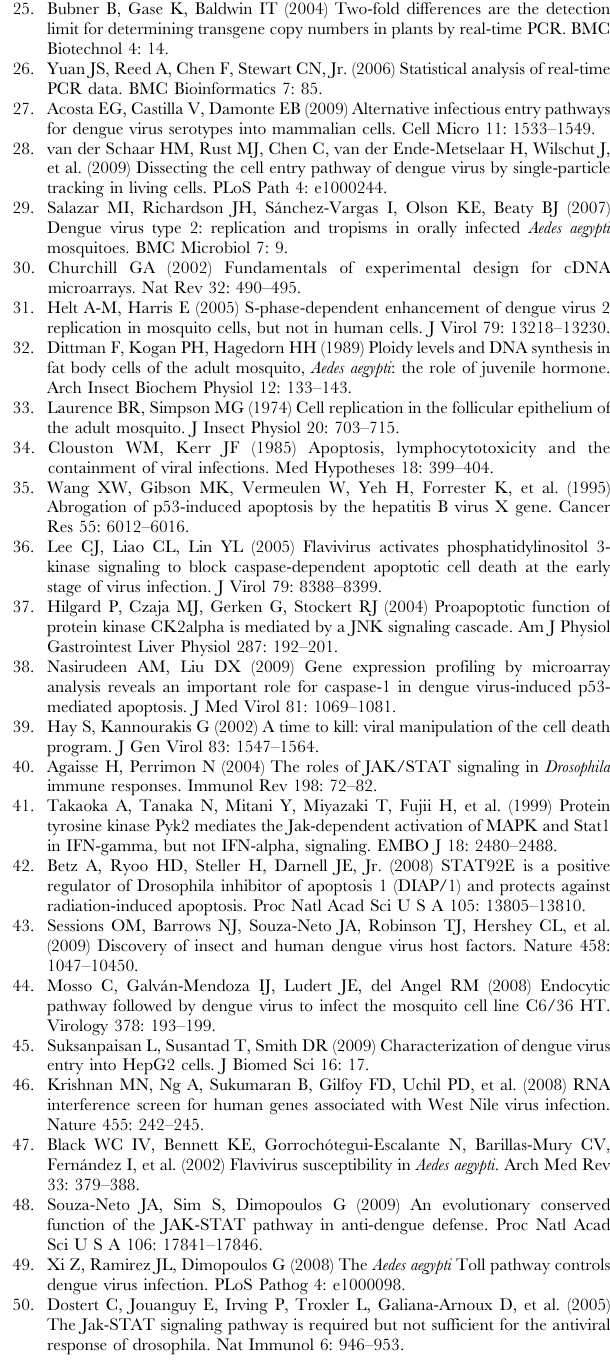
Table S2 List of selected genes that are expressed in modular manner. The associations of these genes to KEGG pathways are shown. Table S3 List of genes and primer sequences (5 9 -3 9 ) used for qRT-PCR validations. Table S4 List of significant DENV responsive genes that showed higher fold-change than the majority of genes belonging to the